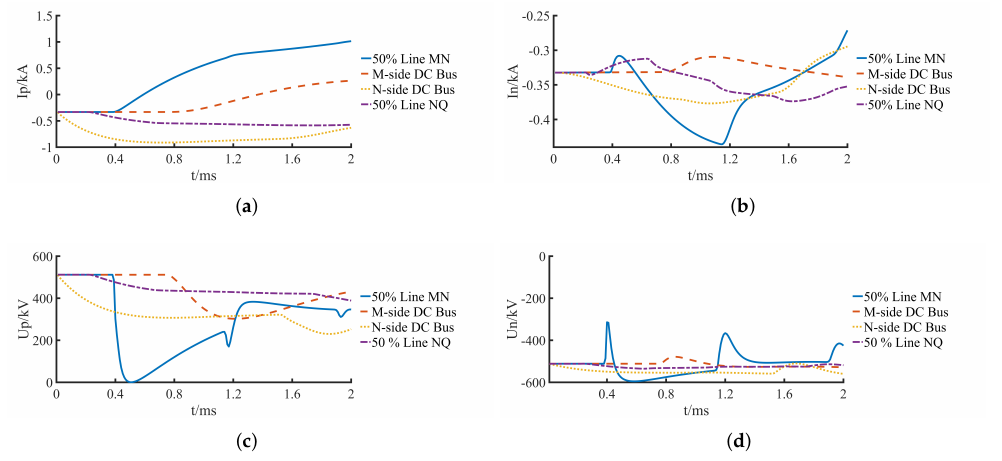
Figure 3. The fault waveforms of the internal fault and the external fault. ( a ) The fault waveforms of Ip; ( b ) The fault waveforms of In; ( c ) The fault waveforms of Up; ( d ) The fault waveforms of Un. The fault waveforms under different faults of the 50% Line MN are shown in Figure